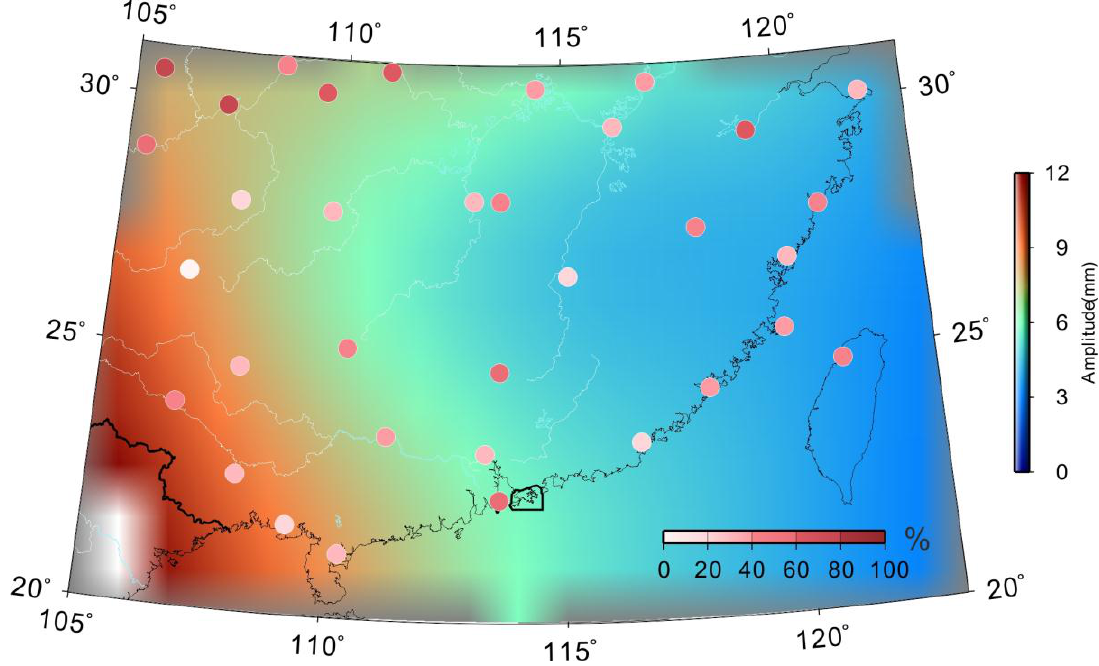
Figure 5. GRACE-derived mass loads amplitude for South China and WRMS reduction (weighted root-mean-squares) for each GPS sites when the GRACE-derived seasonal signals removed from GPS time series. The colored dots are the values of WRMS reduction for all GPS sites.